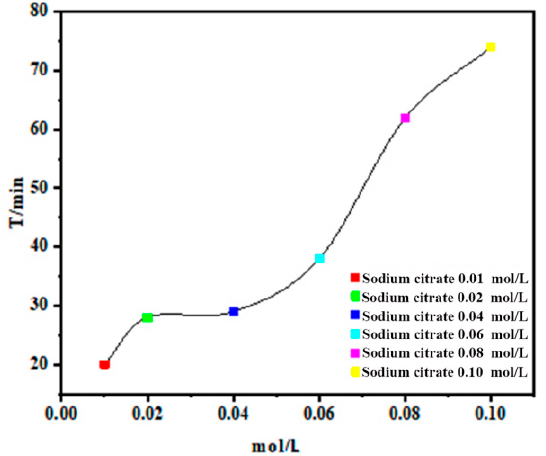
Figure 2. The effect of Ci-Na concentration on desulfurization time. SO 2 = 2300 ppm, gas flow = 1.68 L/min and absorption solution = 60 mL and 25 ° C.